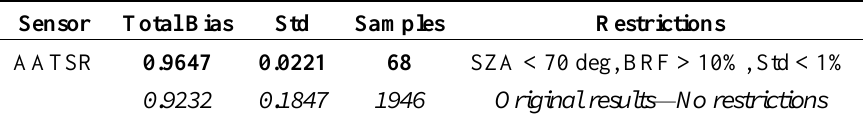
Table 4. Summary of results for all SNO match-up targets for the AVHRR-heritage channel at 1.6 µm based on Advanced Along-Track Scanning Radiometer (AATSR) inter-comparisons with MODIS on AQUA. The total bias is expressed as the relative bias ( i.e. , reflectance factor quota).